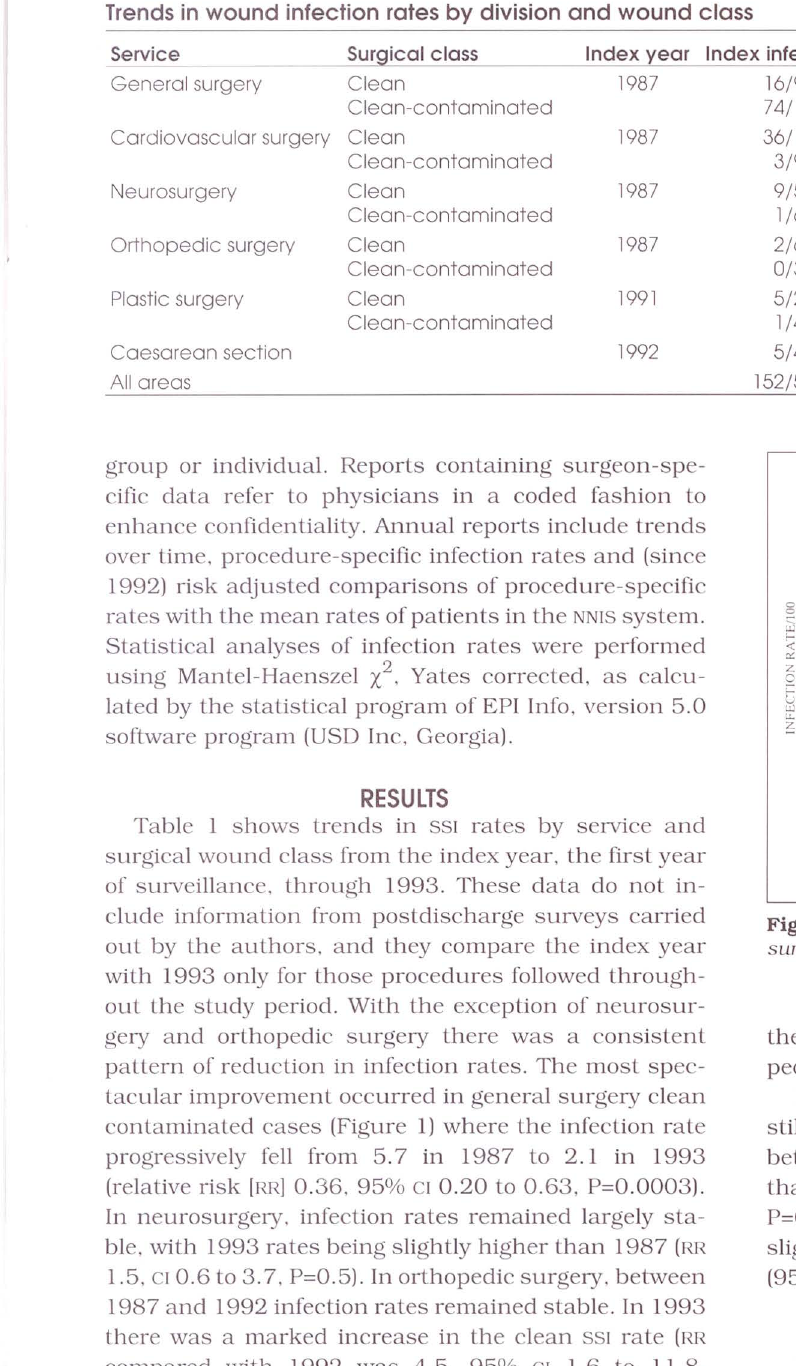
Trends in wound infection rates by division and wound class